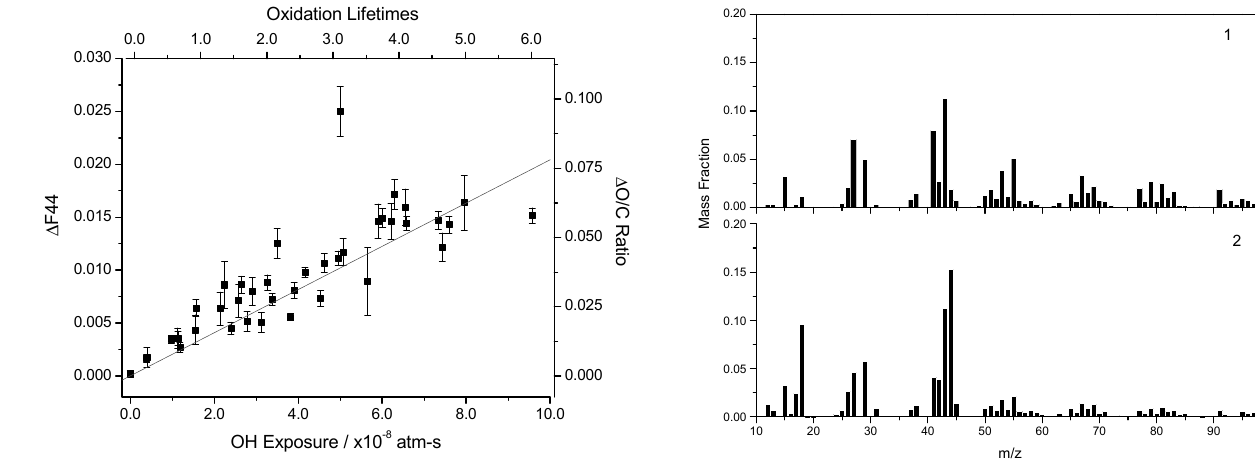
Fig. 5. PMF profiles for A1 and A2 PMF factors deconvolved from SOA1 oxidation